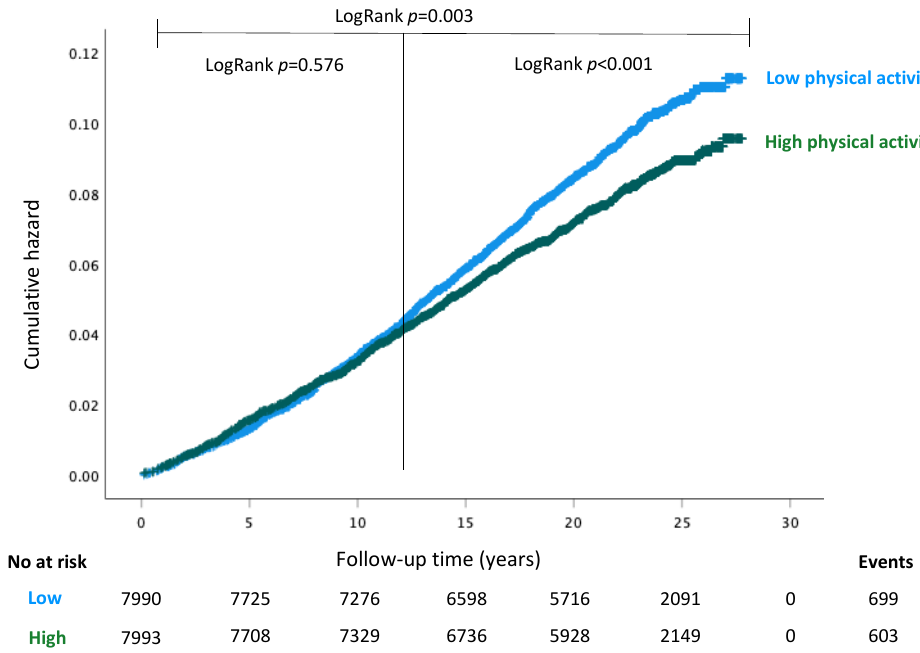
Figure 2. Kaplan–Meier estimates of cumulative hazard for incident breast cancer for all women with Figure 2. Kaplan – Meier estimates of cumulative hazard for incident breast cancer for all women LogRank tests presented for the entire follow-up period, and for the short- (0–11 years) and long-term with LogRank tests presented for the entire follow-up period, and for the short- (0 – 11 years) and (12+ years) follow-up periods long-term (12+ years) follow-up periods separately.